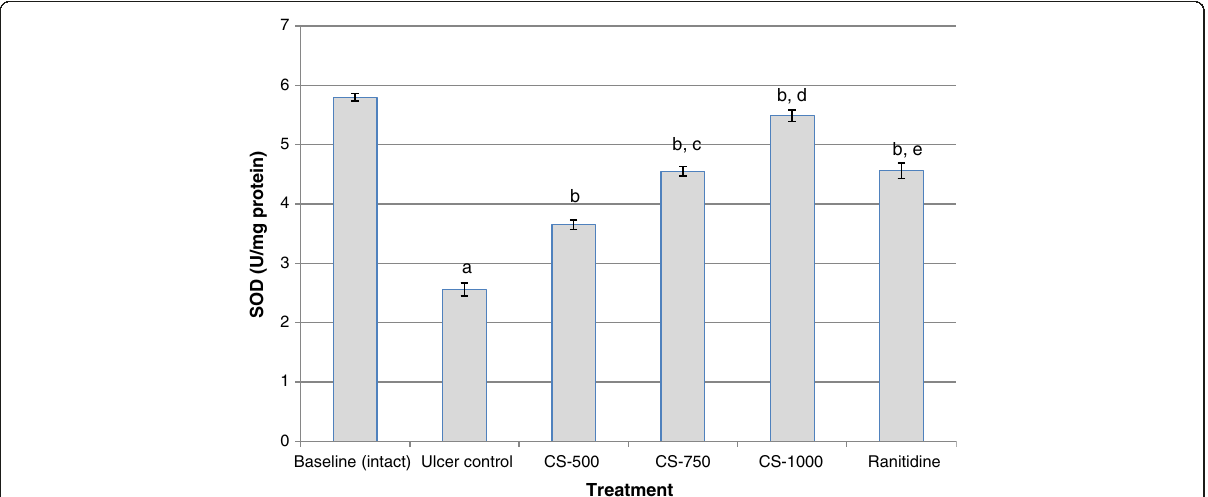
Figure 3 Effect of C. sieberiana (CS) plant extract on mucosal superoxide dismutase activity in F 344 rats. a p<0.001 compared with baseline (intact); b p<0.001 compared with ulcer control; c p<0.001 compared with CS-500; d p<0.001 compared with CS-750; e p<0.01 compared with CS-1000; Values are Mean ± SEM of 6 animals. Statistical significance was determined by one-way analysis of variance (ANOVA) followed by Dunnett ’ s post hoc t test.